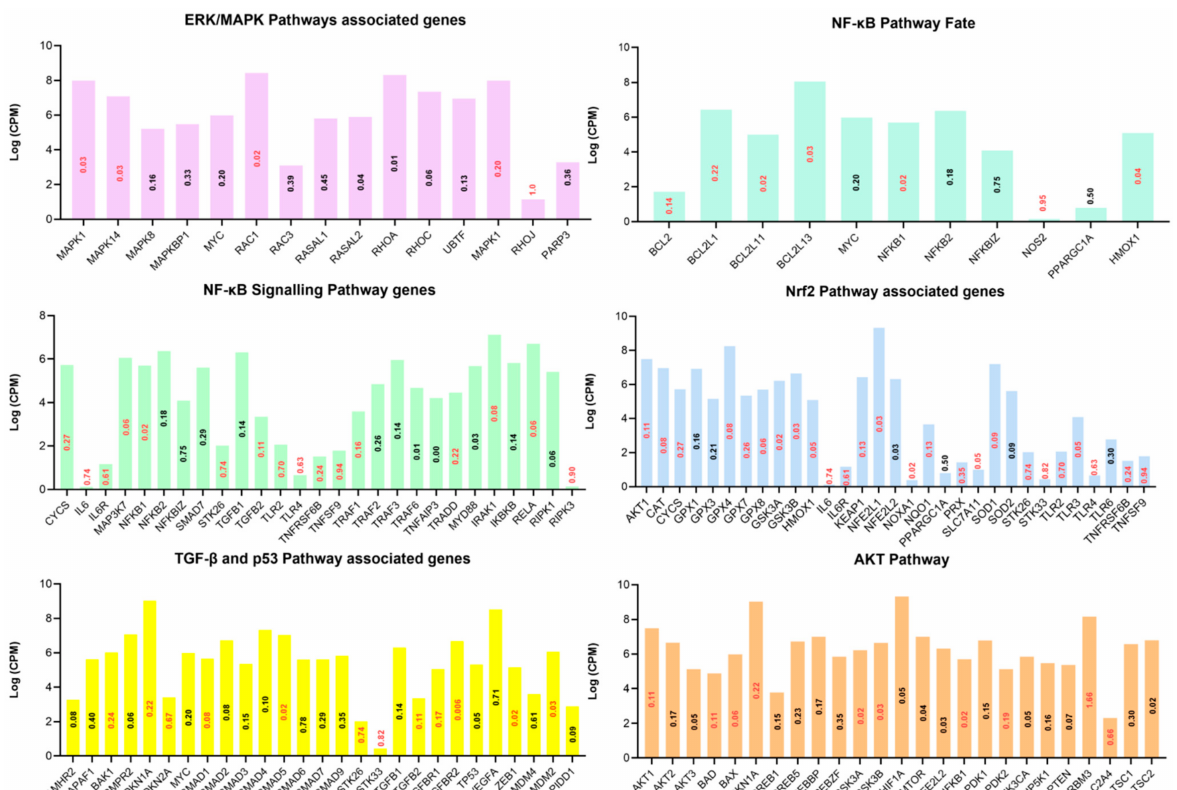
Figure 5. Bar charts based on the manual query of the differentially expressed genes (DEGs). Various important pathways as presented by the titles of the bar charts and associated genes are shown. The y-axis represents the log of counts per million and the log of fold change is presented inside the bars (red upregulated and black downregulated) against respective genes on the